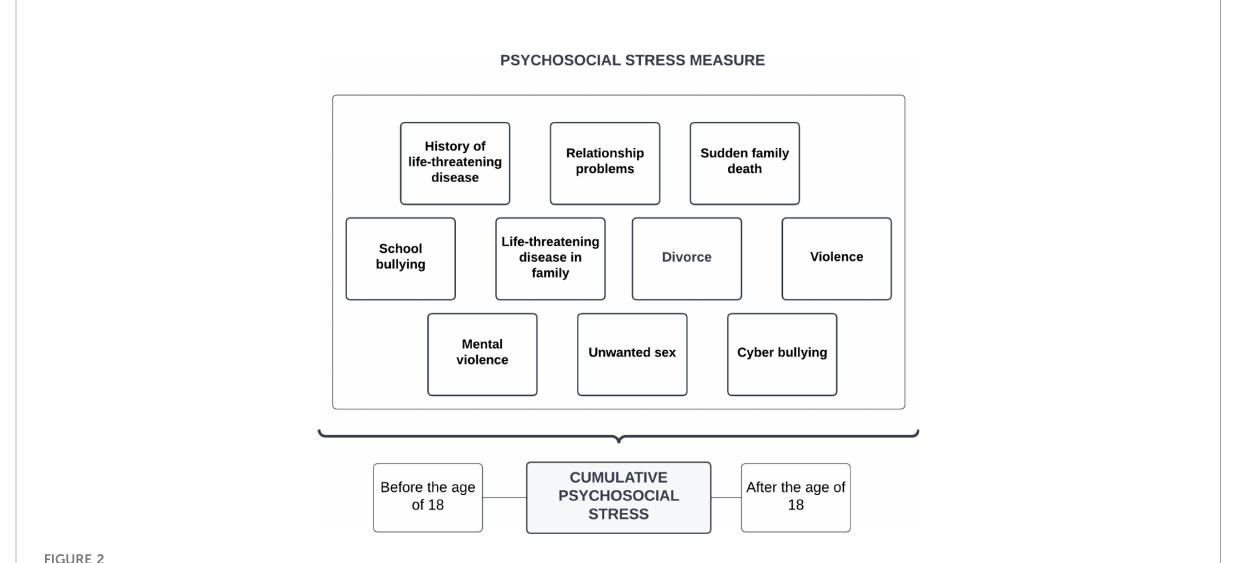
FIGURE 2 Variables included in the psychosocial stress